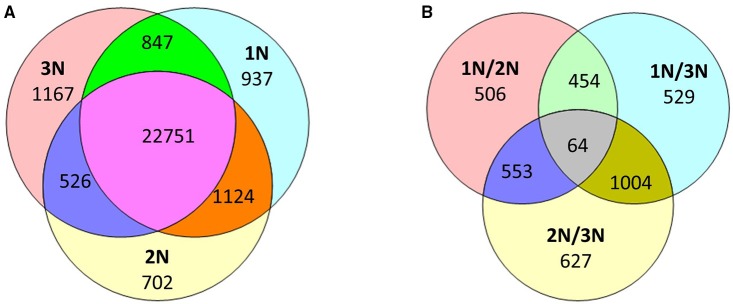
(A) Number of methylated genes that were unique or shared among the three rice lines (1N is monoploid, 2N is diploid, and 3N is triploid). (B) Number of differentially methylated genes among the three rice lines and between any two rice lines.